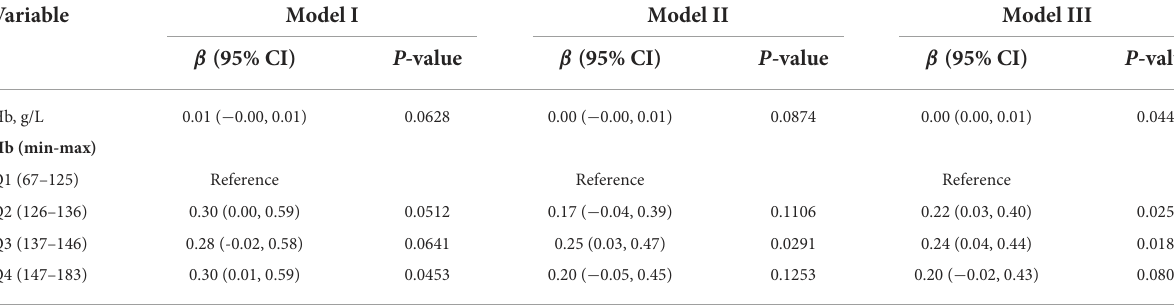
TABLE 3 Relationship between Hb (g/L) and TGs (mmol/L) in different models. Variable